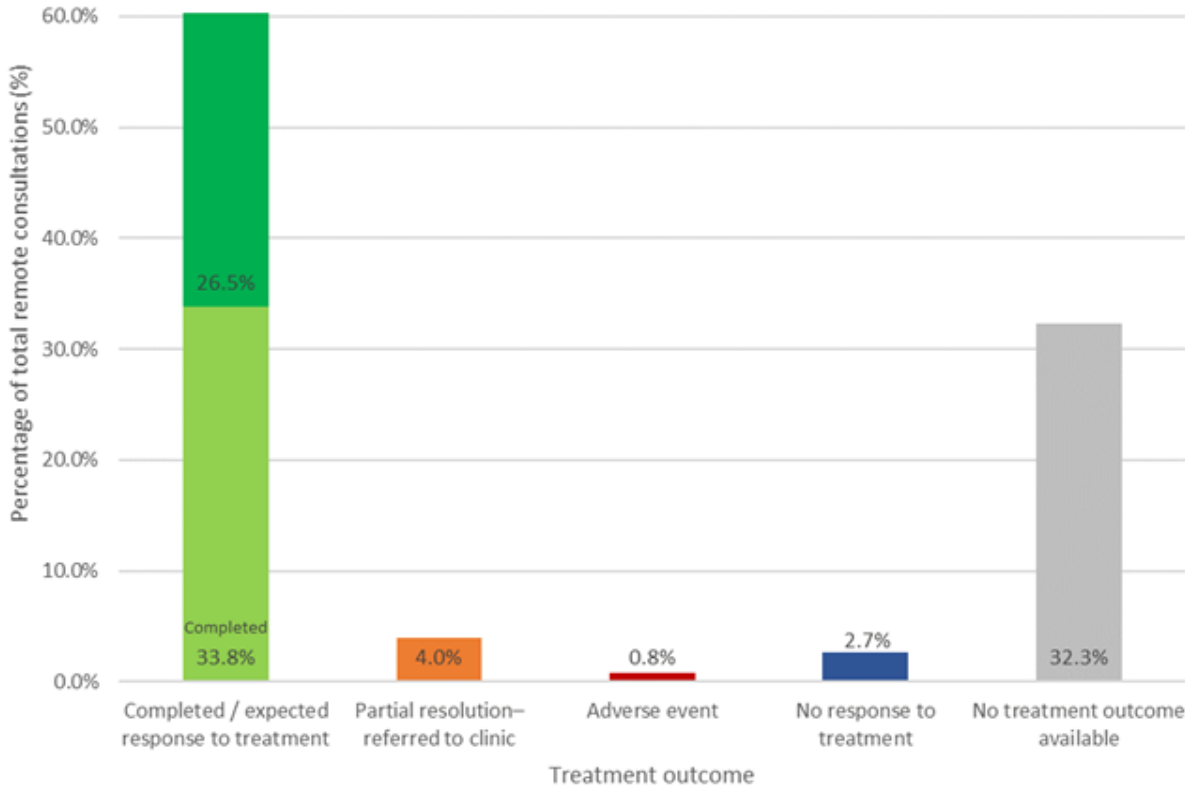
Figure 6: Treatment outcomes for consultations with remote prescriptions A graph depicting outcomes of treatment for patients managed remotely that had a POM-V / POM prescription as a result of completed remote veterinary led video consultations via a dedicated veterinary telemedicine smartphone app. between 1 April – 31 October 2020; showing the outcomes of treatments with POM-V / POM medications separated into the following outcome categories: complete / expected response to treatment; partial response to treatment with referral into a physical practice; adverse event; no response to treatment; and no treatment outcome